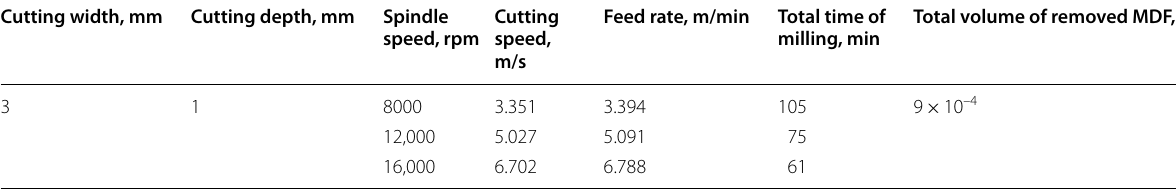
Table 1 Milling parameters at three cutting speeds Cutting width, mm Cutting depth, mm Spindle